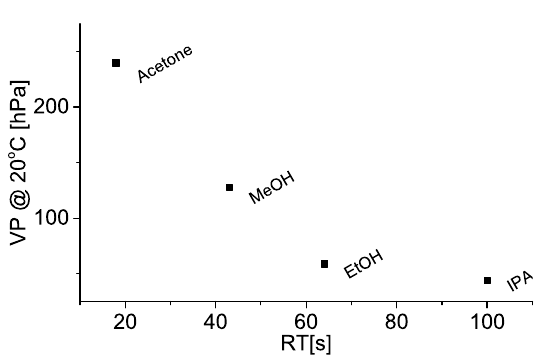
Figure 6. Dependence of solvent vapour pressure (VP) at 20 ◦ C with respect to resistance rise time (RT) or (from left to right) acetone, methanol (MeOH), ethanol (EtOH), and isopropanol (IPA). Details are given in Section 4.